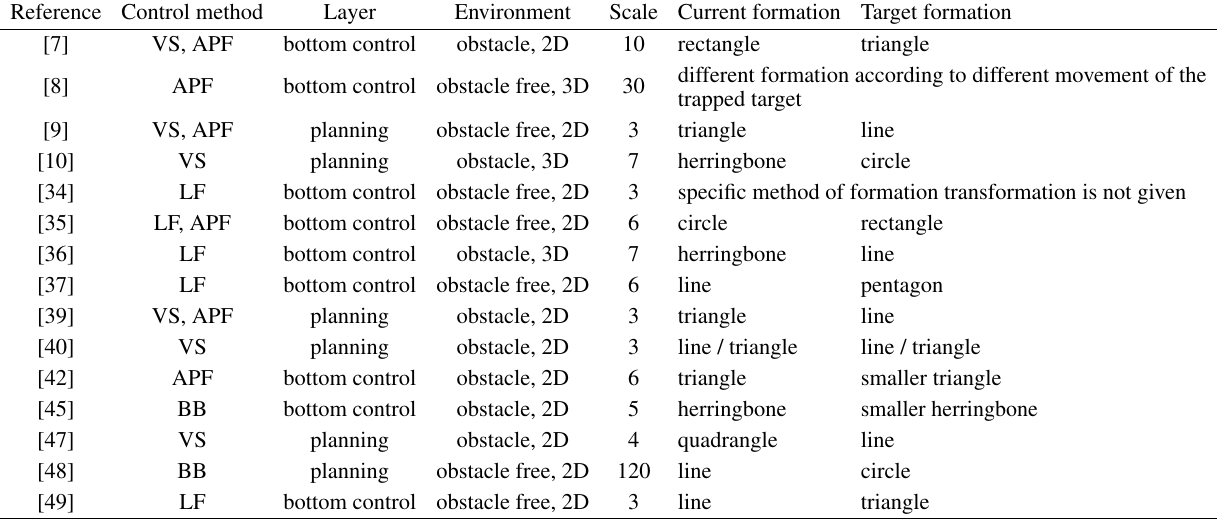
Table 4 Characteristics of the above studies. LF: leader-follower method; VS: virtual structure method; APF: artificial potential field method; BB: behavior-based